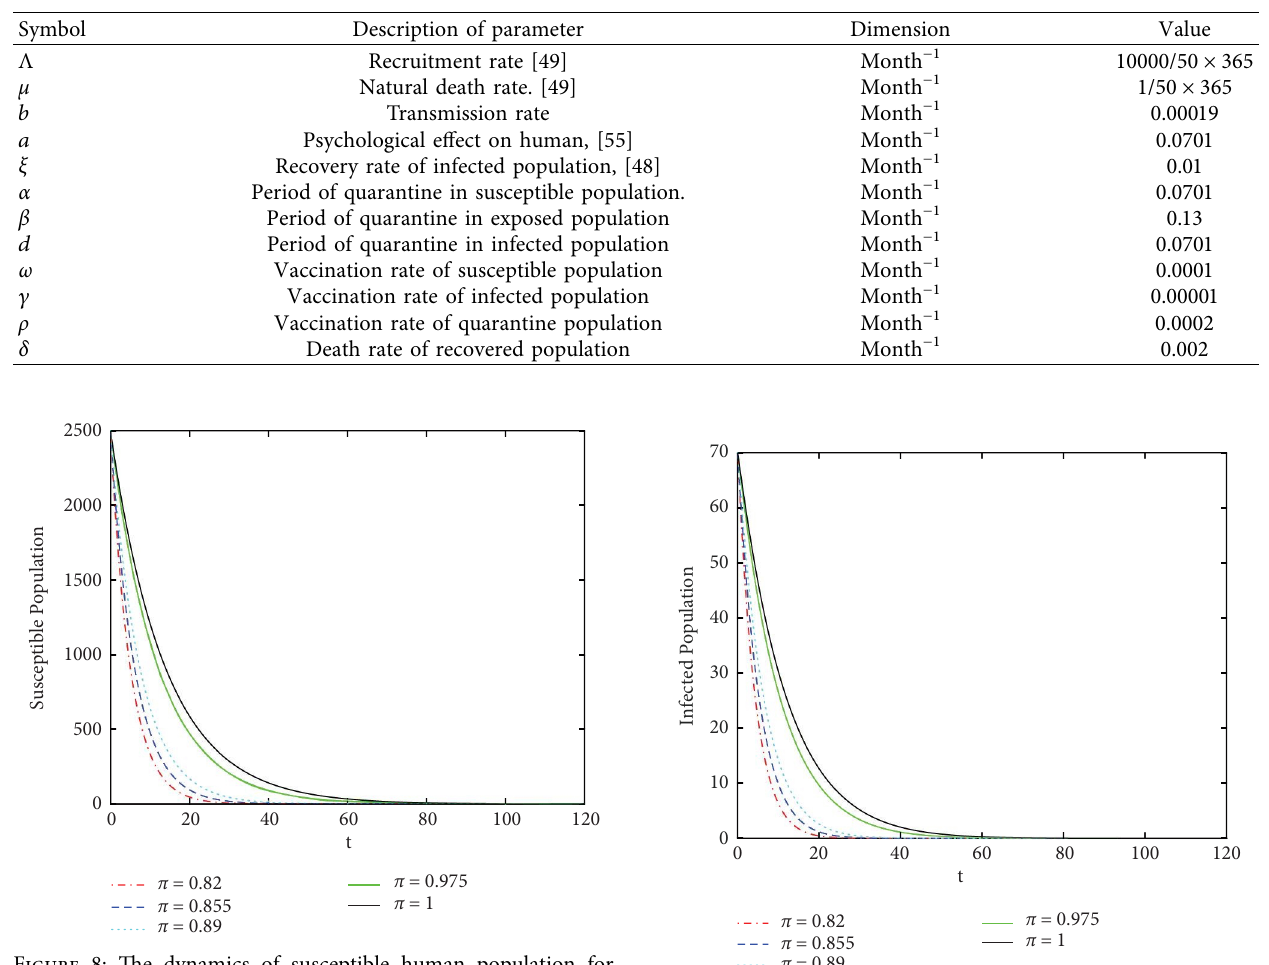
Table 4: Table for numerical values of parameters.